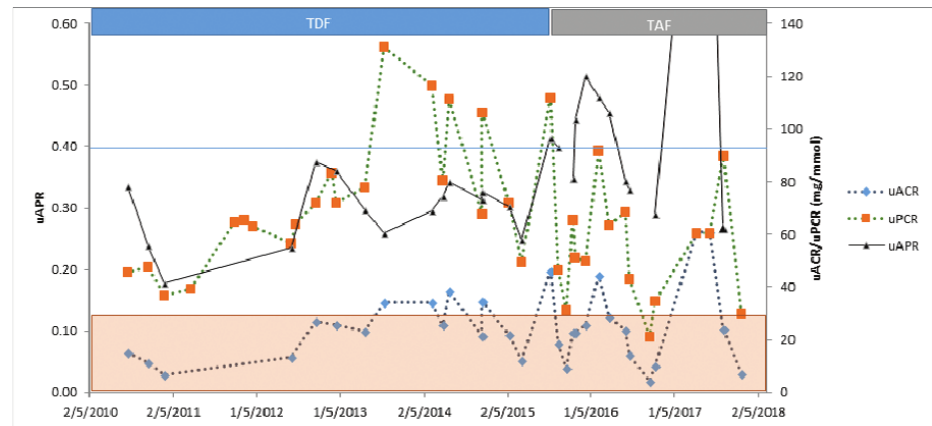
Figure 1. This graph illustrates the reduction in proteinuria (uPCR), initially without much change in albuminuria (uACR) after starting TAF. This increases uAPR above 0.4 for the first time since the patient developed proteinuria. The significance of uAPR with low total urine protein is unknown and is not shown when uPCR < 30 mg/mmol shaded (as per Ref